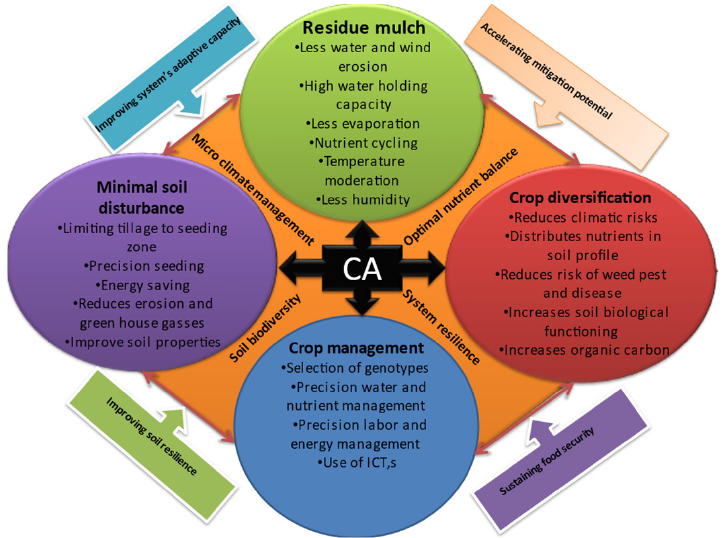
Figure 1. Conservation agriculture-based management practices and their benefits for the agro-eco- system.